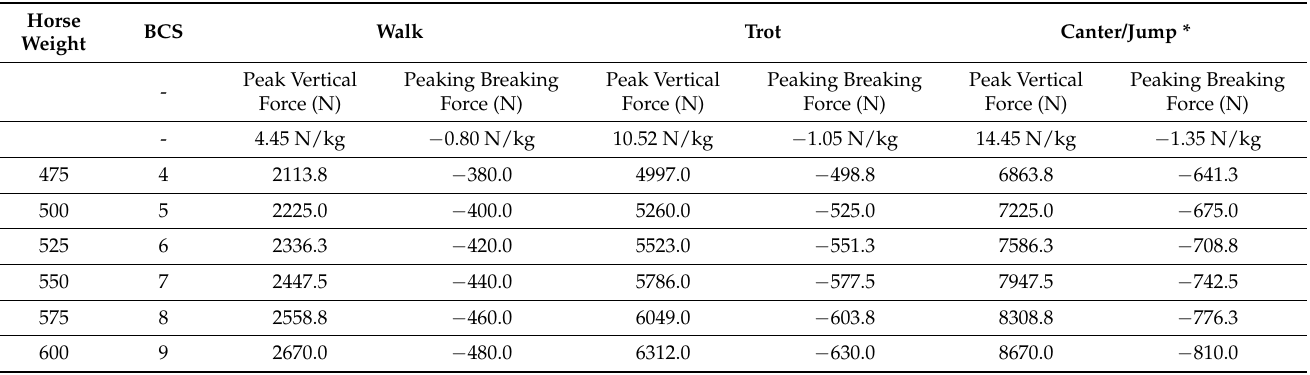
Table 2. Estimated forces on limbs with horses of varying body condition scores and thus body